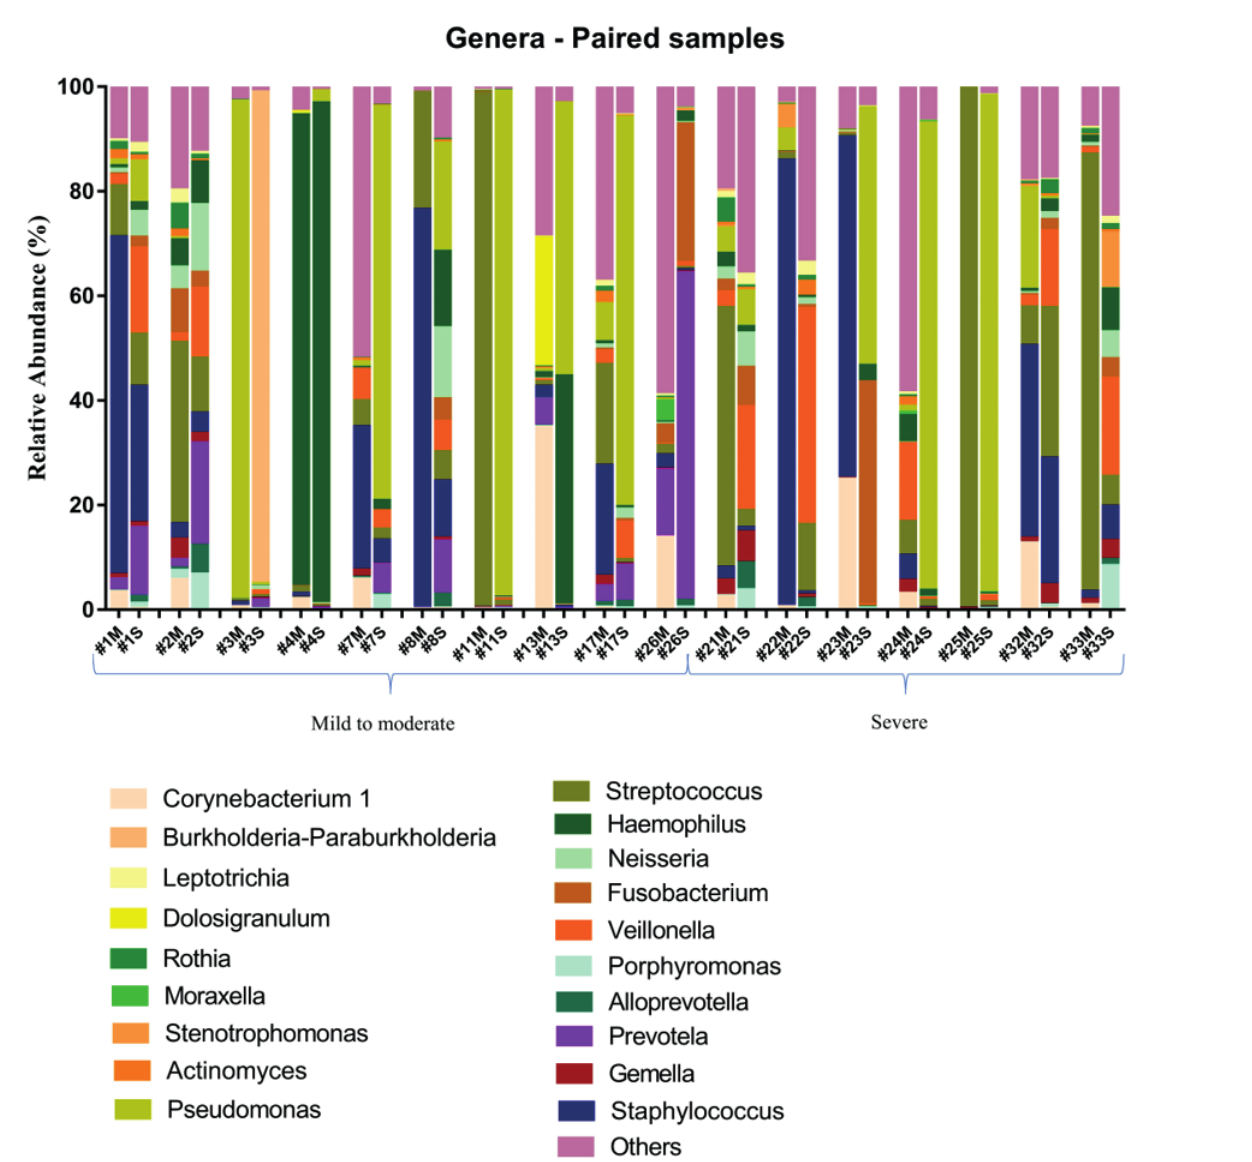
Figure 2. Relative abundance of main bacterial genera observed in middle meatus and sputum in paired samples from each patient with mild to moderate and severe lung disease. (#: identification number of each patient. M: middle meatus samples; S: sputum samples). There is a difference in microbiome composition from both disease state, with Streptococcus , Staphylococcus and Prevotella being shared in both samples from each patient with mild to moderate lung disease, and a distinct microbiome composition in both samples from each patient with severe lung